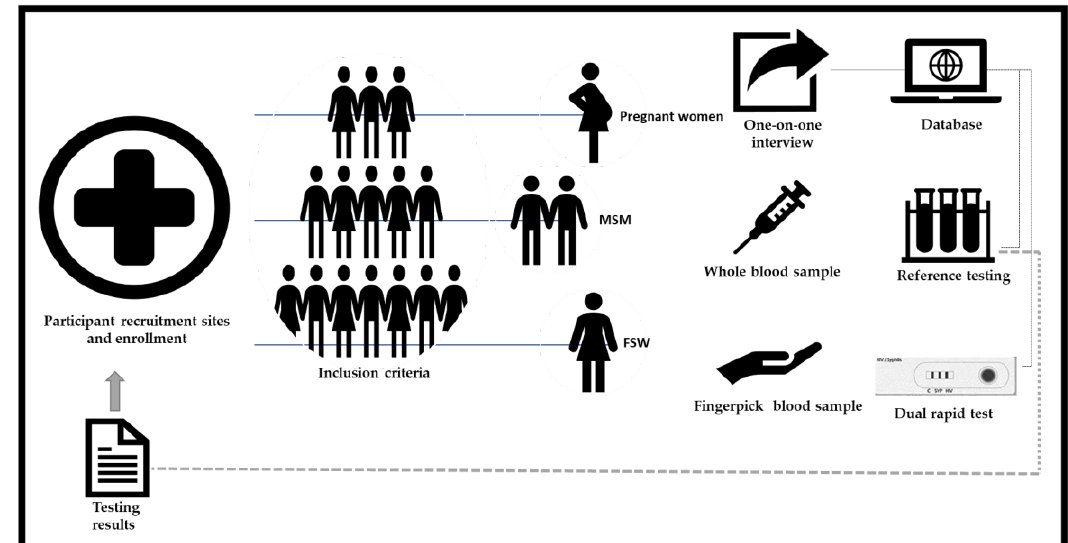
Figure 1. Key populations enrollment and testing procedures.